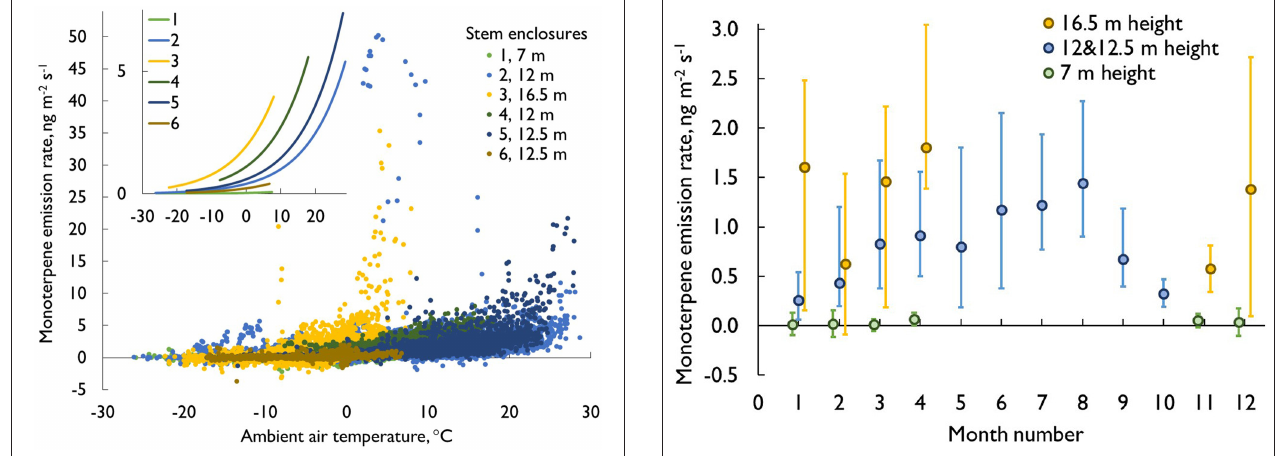
between 0.05 and